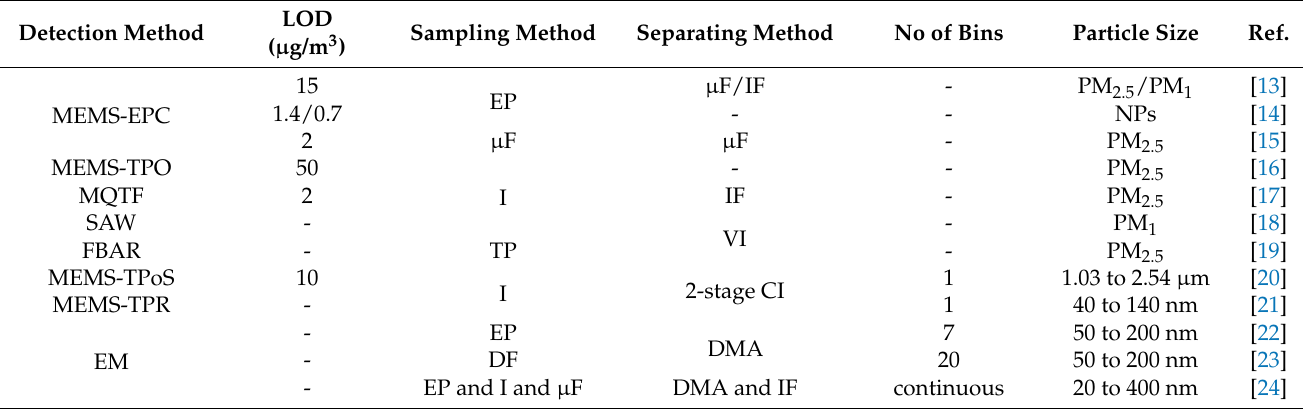
Table 1. Gravimetric aerosol particle detectors for personal air-quality monitoring. For comparison, three electrometer-based (EM) setups are included offering the capability of particle separation into several size bins. Abbreviations are given below 1 .